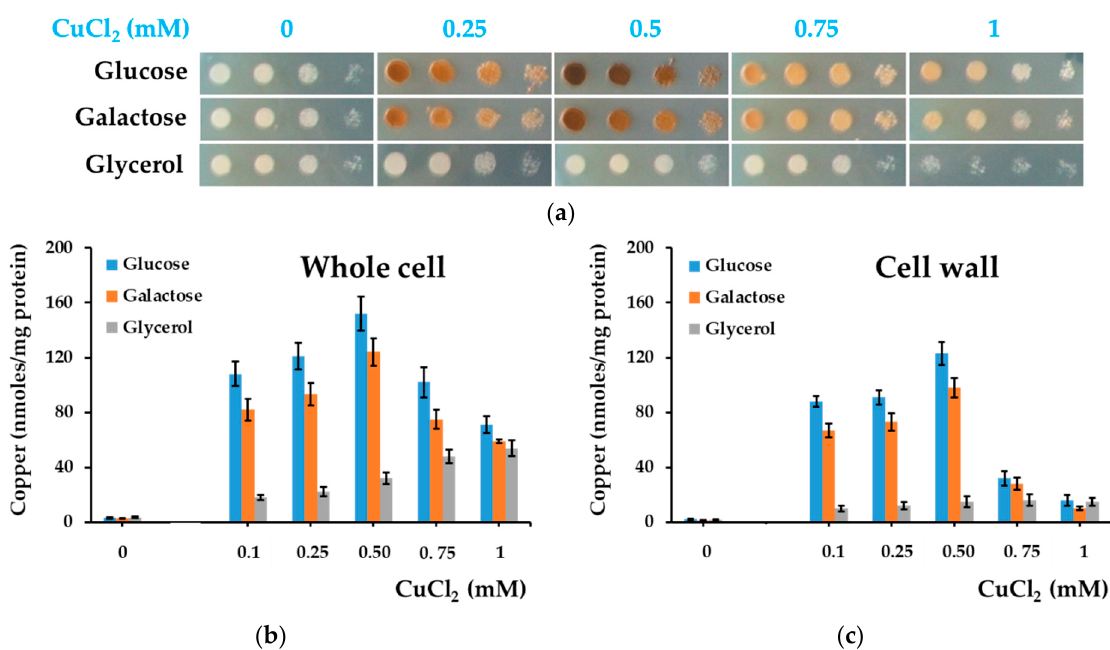
Figure 5. Coloration of Saccharomyces cerevisiae and accumulation of copper at higher copper concentrations. ( a ) Cell suspensions of strain BY4741 were spotted in serial dilution onto MM/Glc (Glucose), MM/Gal (Galactose), or MM/Gly (Glycerol) media with various concentrations of CuCl 2 . Plates shown were photographed after 6 days of incubation at 28 °C. ( b ) Copper accumulation by cells grown statically on MM agar media. Cell suspensions were spotted on agar plates (approximately 10 6 cells/5 µL spot) and incubated at 28 °C. ( c ) Copper associated with cell walls. Cell patches were harvested after 6 days of incubation and processed for copper assay, as described in Section 2. The cells used to determine whole-cell copper, cell wall copper, and total cell protein used for normalization belonged to the same batch. Values are mean ± SEM of triplicate determinations done on three biological repeats.